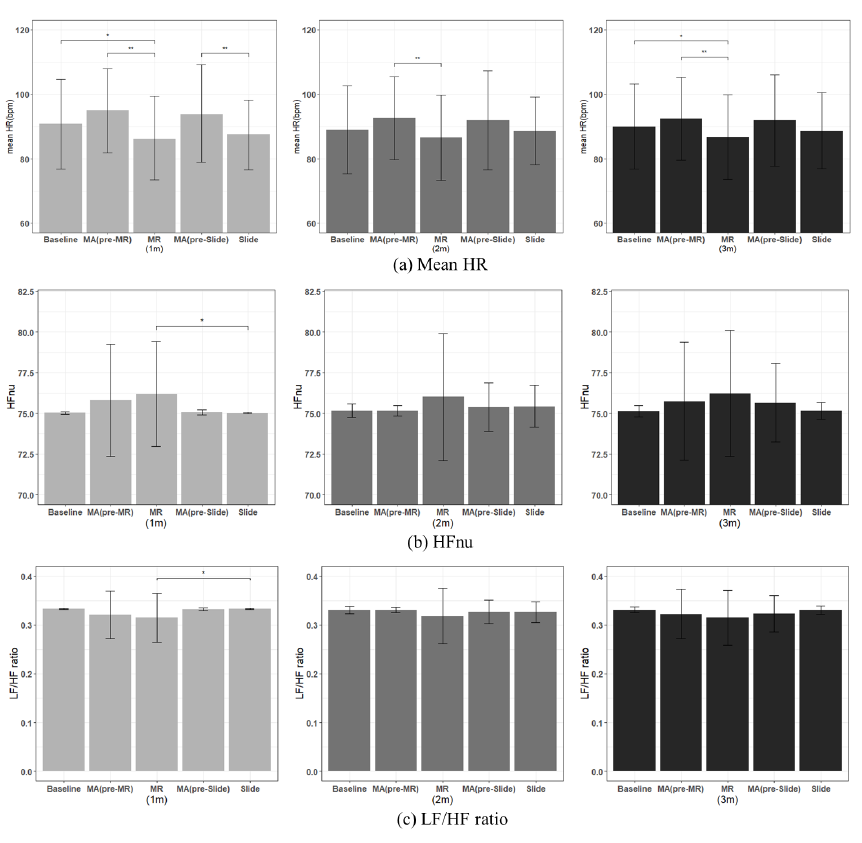
Figure 9. Comparison of mean HR and HRV results between average of baseline, MA (pre-MR), MR, MA (pre-slide), and Slide (the slide show). N = 30, mean ± standard error, *: p < 0.05, **: p < 0.01; significant differences verified using Friedman test, Nemenyi post hoc